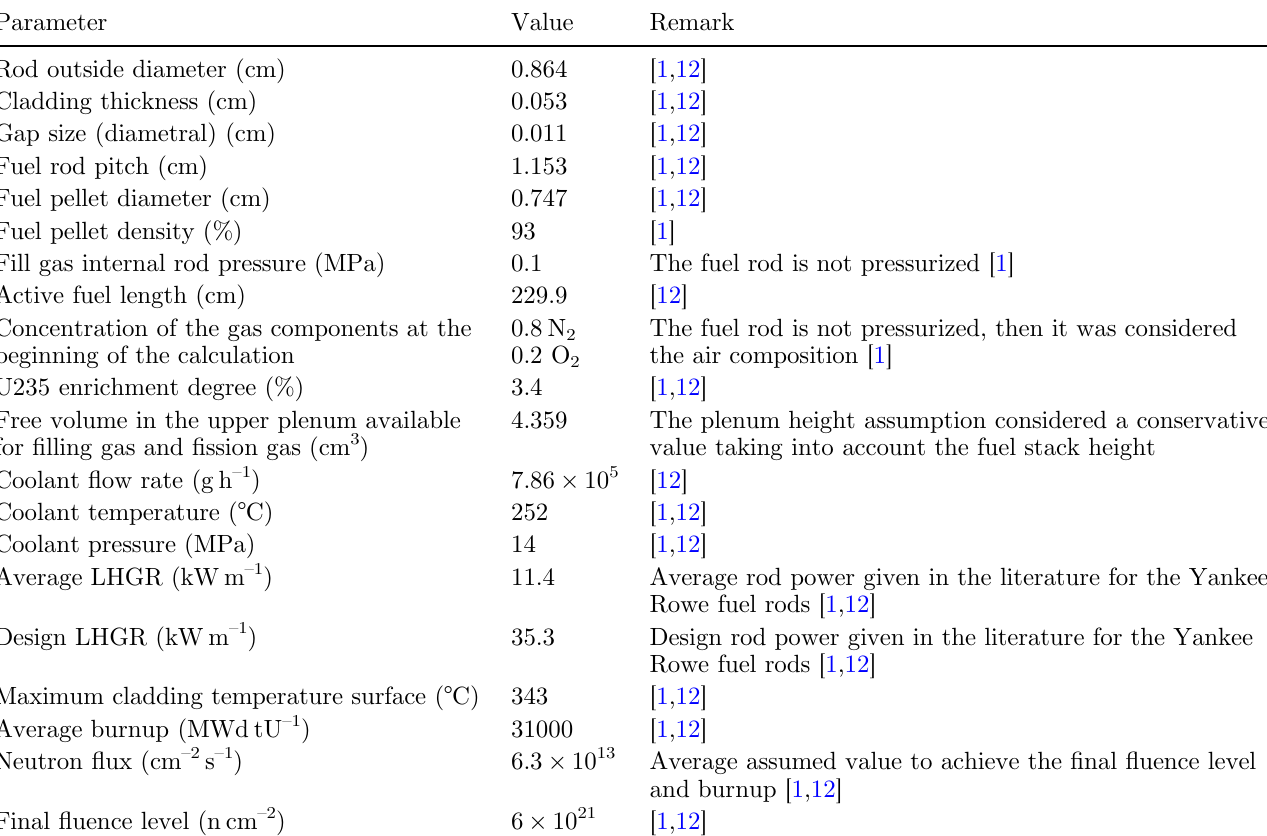
Table 2. Yankee Rowe general data and assumptions.